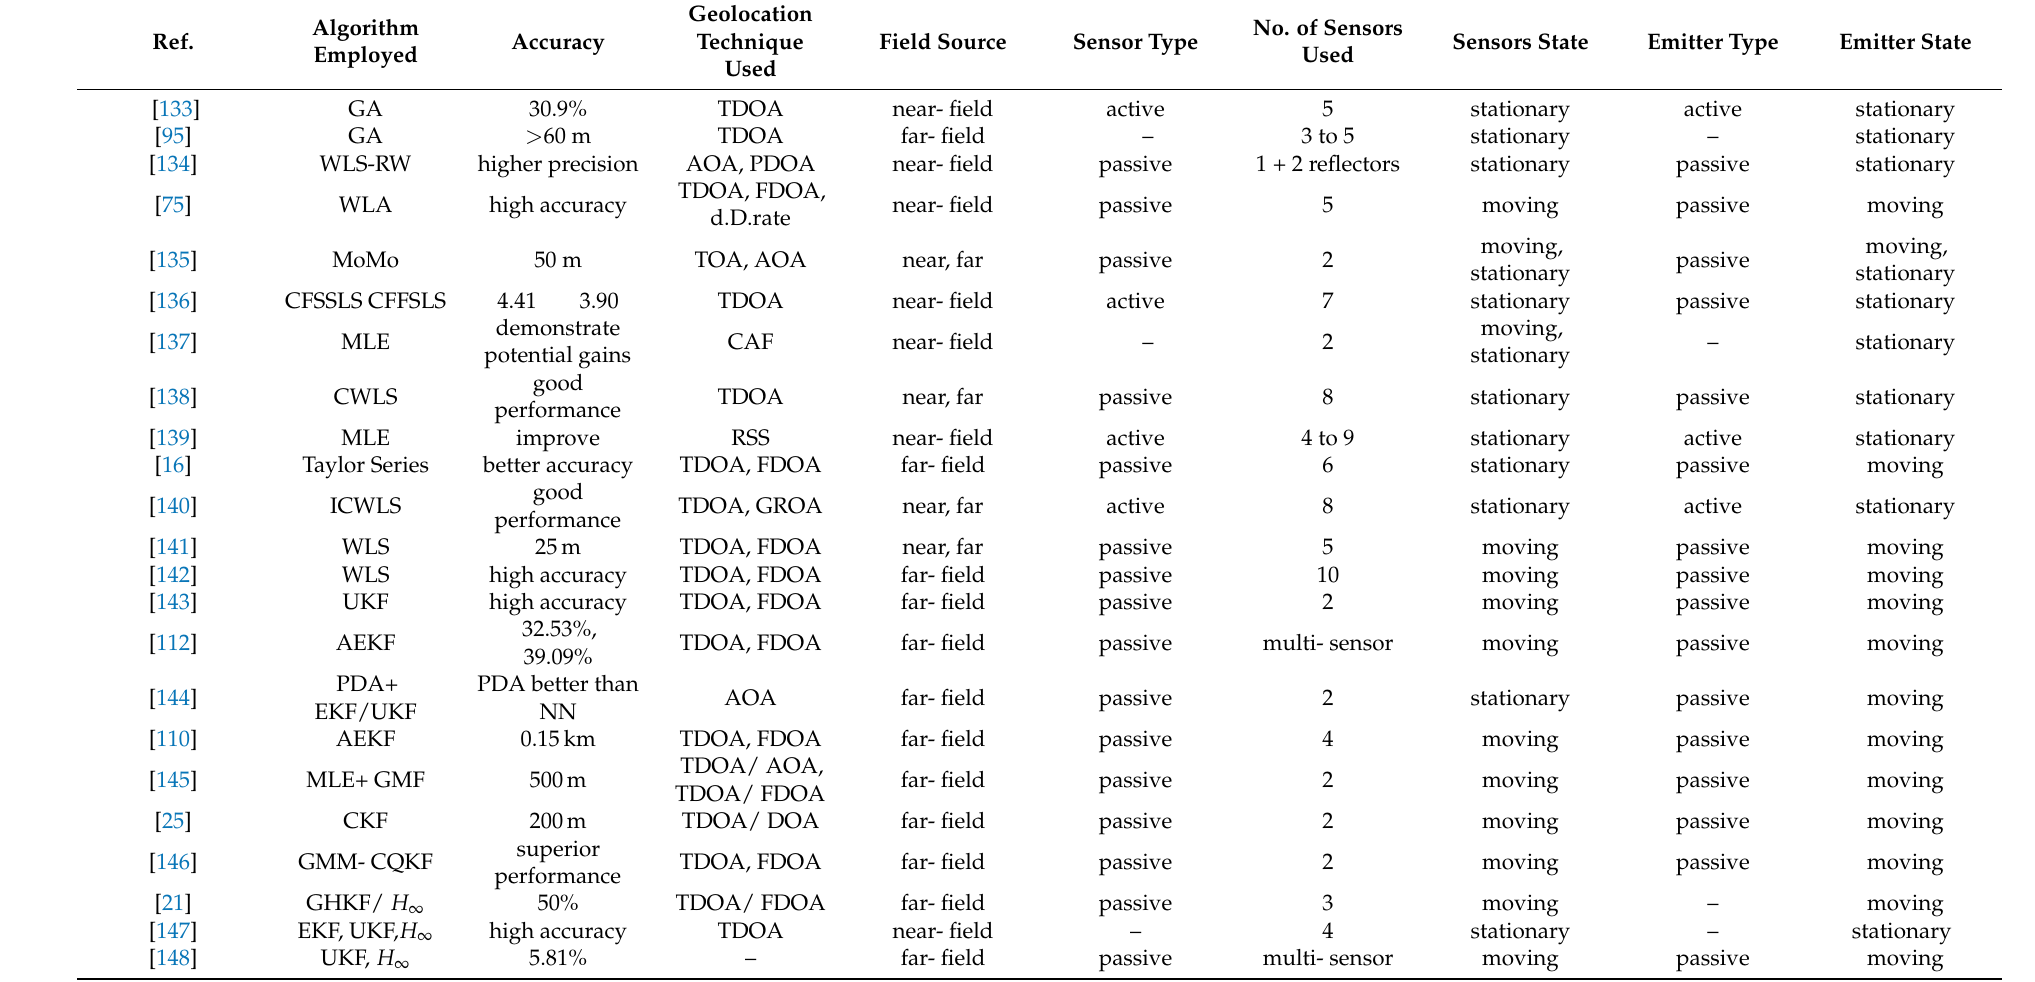
Table 5. Summary of geolocation and target tracking algorithm specifications employed in the state-of-the-art methods.